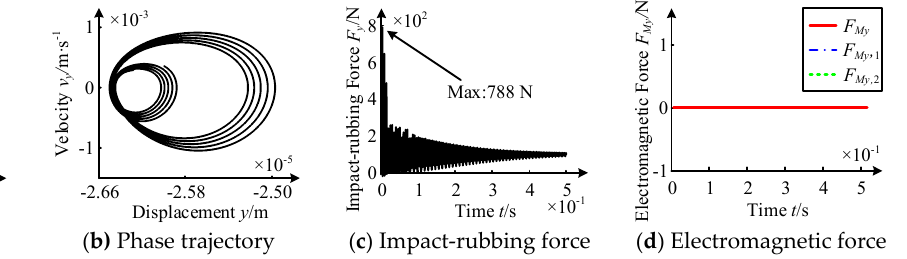
According to Figure 15, the bouncing stage mainly occurs within 0.02 s. Both the rotor